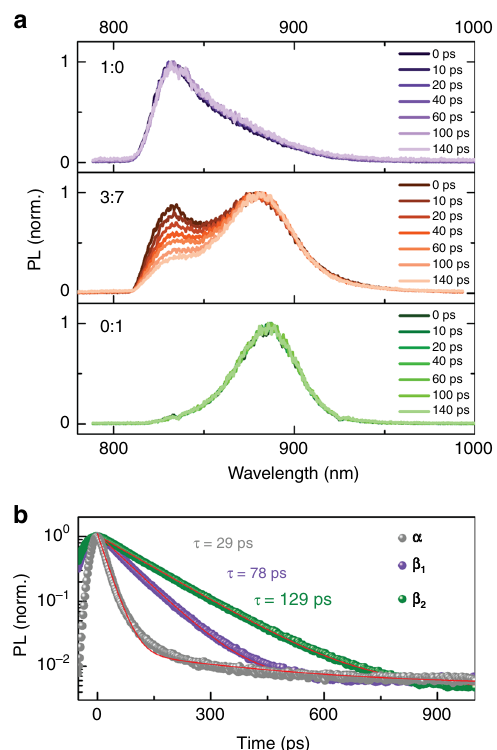
Fig. 2 Time-resolved photoluminescence in mixed solvents. a Normalized time-resolved photoluminescence (TRPL) spectra recorded at various time delays for a solution of D-PDPP4T-HD in 1:0, 3:7 and 0:1 (v/v) of chloroform:1,2,4-trichlorobenzene (CF:TCB). The polymer concentration is 0.4 µ M. Excitation was performed at 800 nm with 80 MHz laser pulse repetition rate. A 808 nm long-pass fi lter was used to suppress the scattered laser pulse. b Emission dynamics of α phase from 0:1 solution at 100 °C with λ ex = 400 nm and λ em = 815 – 865 nm, β 1 phase from 1:0 solution with λ ex = 800 nm and λ em = 825 – 840 nm, and β 2 phase from 0:1 solution with λ ex = 800 nm and λ em = 870 – 890 nm